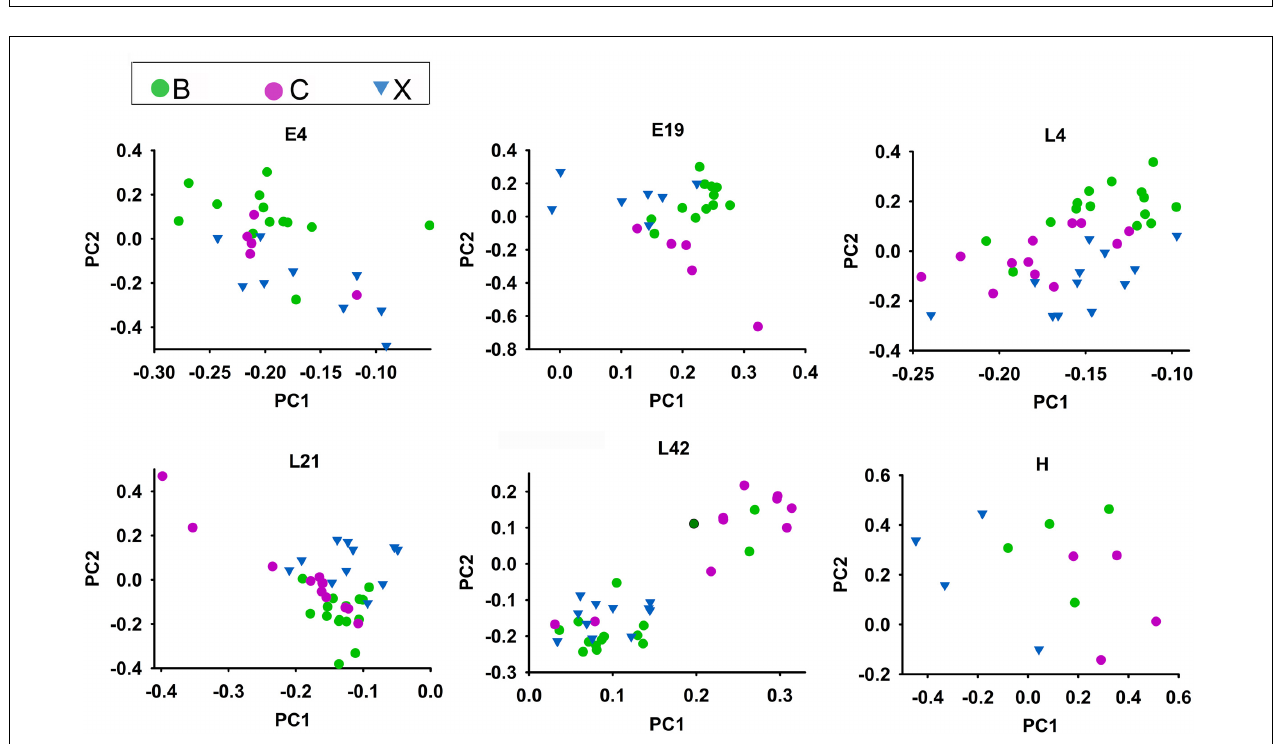
FIGURE 4 | Significant differences in microbial metabolic pathways at different stages. Extended error bar plot indicates the difference in mean proportion of microbial metabolic pathways between the two groups along with the associated confidence interval of this effect size and the p -value of Welch’s t -test ( p < 0.05).